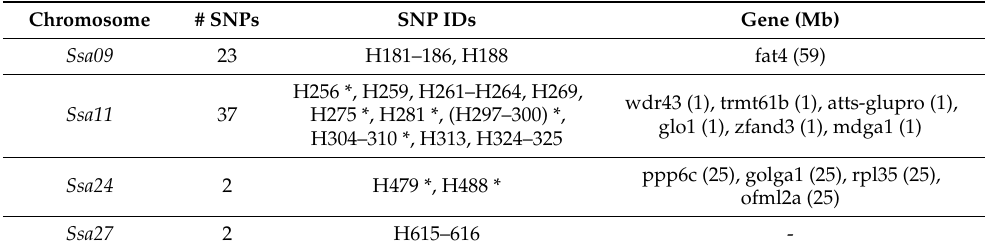
Table 4. Genes that include (or are located at less than 1000 kb) significant SNPs for the Atlantic– Scotland comparison detected by all three haplotype-based methods. SNPs were annotated using the online tool SalmoBase (https://salmobase.org/, accessed on 20 May 2021). The #SNPs refer to the number of all SNPs detected by all three methods in that chromosome, not only to those included in genes. The latter are indicated by SNP IDs. In parentheses, the Mb position in the corresponding